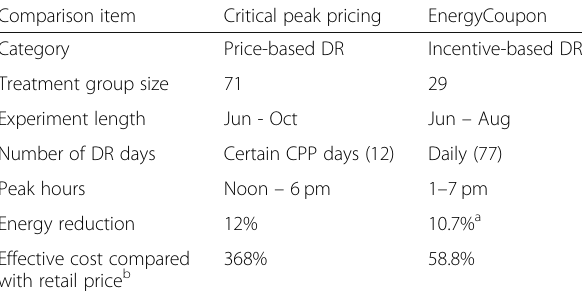
Table 5 Comparison between EnergyCoupon and